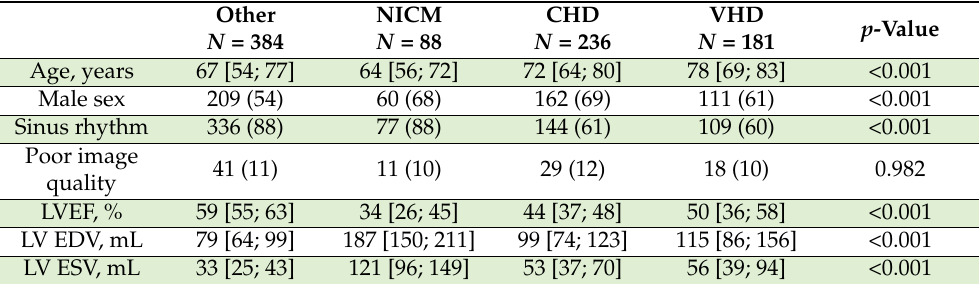
Table 3. Characteristics of the Main Clinical Diagnosis.